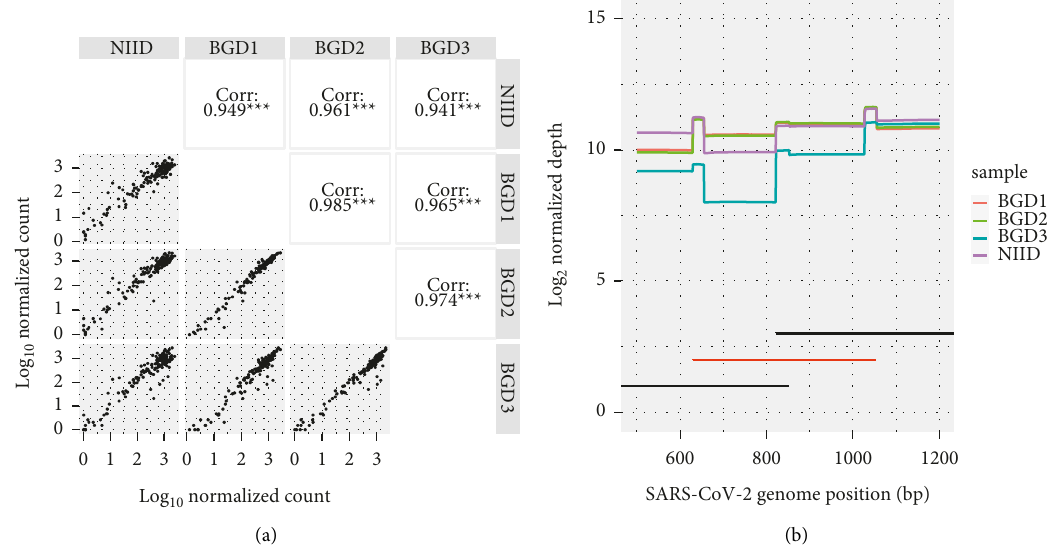
Figure 2: Amplicon bias among four samples is largely consistent but influenced by SNVs on the primer annealing site. (a) Comparison of normalized counts for each amplicon from NIID and three Bangladesh clinical samples (BGD1, 2, and 3). Log10-transformed amplicon counts normalized from 100,000 mapped reads are shown. Pairwise comparisons with Pearson’s correlation values are shown in the upper right quadrant. (b) Read depths for each sample in the region spanning region_002 (left black line), region_003 (middle red line), and region_004 (right black line) are shown. The SARS-CoV-2 sequence from BGD3 had a mutation on the reverse primer for region_003. Read depths were normalized from 100,000 mapped